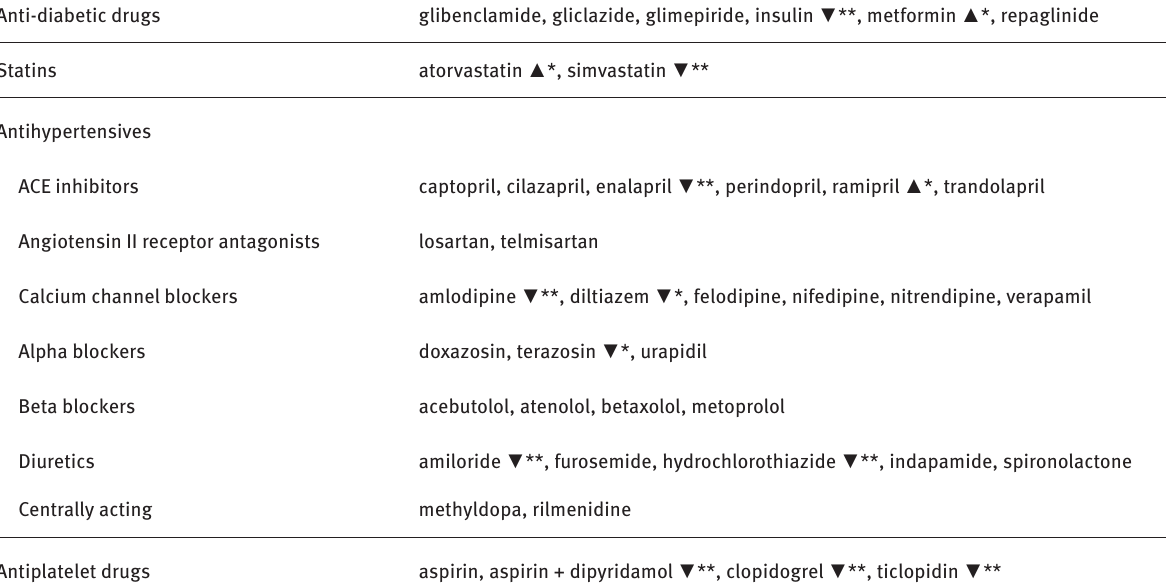
Table 1: Drugs monitored in this study that had a statistically significant increase or decrease in use between 2005 and 2012 Anti-diabetic